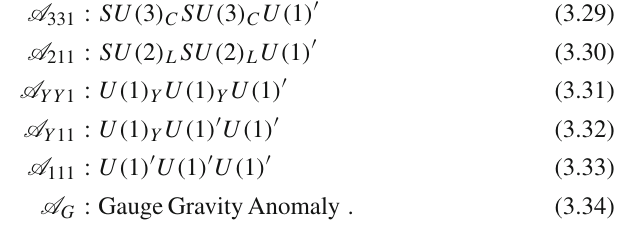
Table 4 Singlet fields θ ij along with their corresponding U ( 1 ) (cid:2) charges and multiplicities M ij . The “ ( − ) ” sign on the weights and charges refers to the singlets in the parentheses